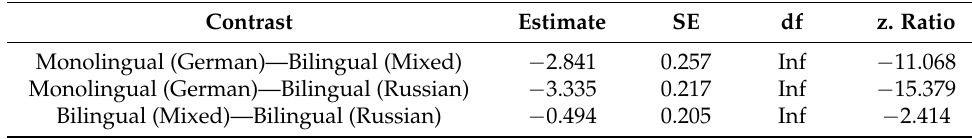
Table A3. German experiment: pairwise comparisons, family